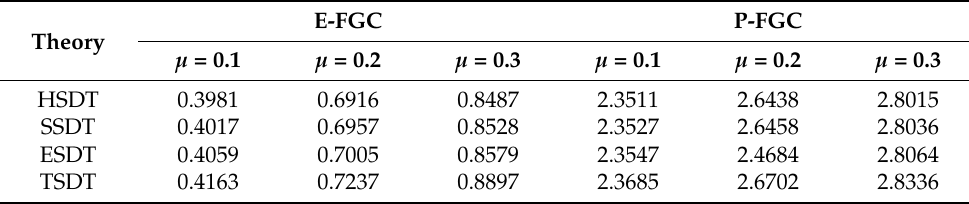
Table 6. Dimensionless critical bucking load for different beam theories, FGC model and CNTs’ volume fractions µ